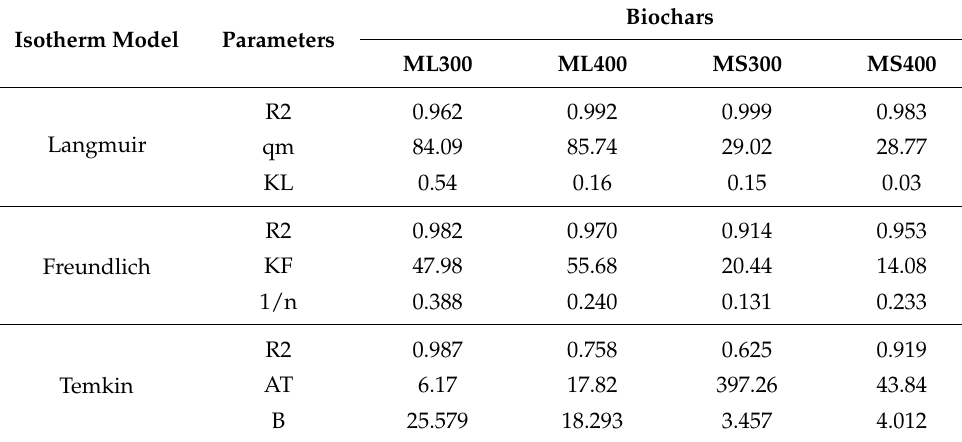
Table 4. Langmuir, Freundlich and Temkin parameters of the isotherms of methylene blue adsorption on the biochars prepared from mugwort post-extraction residue.